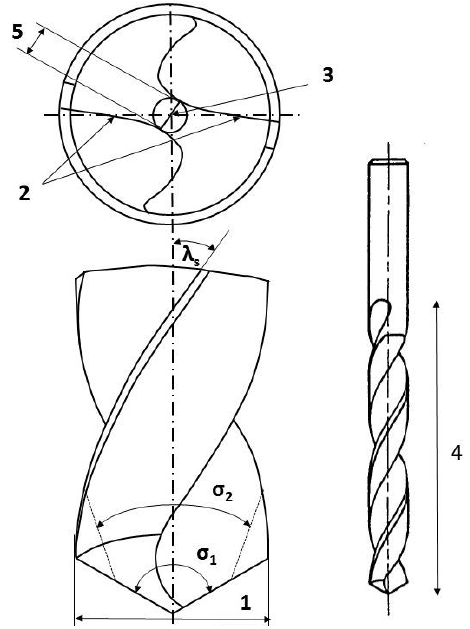
Figure 2. Drill geometry with: (1) tool diameter, (2) main cutting edges, (3) chisel edge, (4) flute length, (5) chisel edge length/core thickness, (λ s ) helix angle, (σ 1 ) point angle, and (σ 2 ) point angle for segmented part.